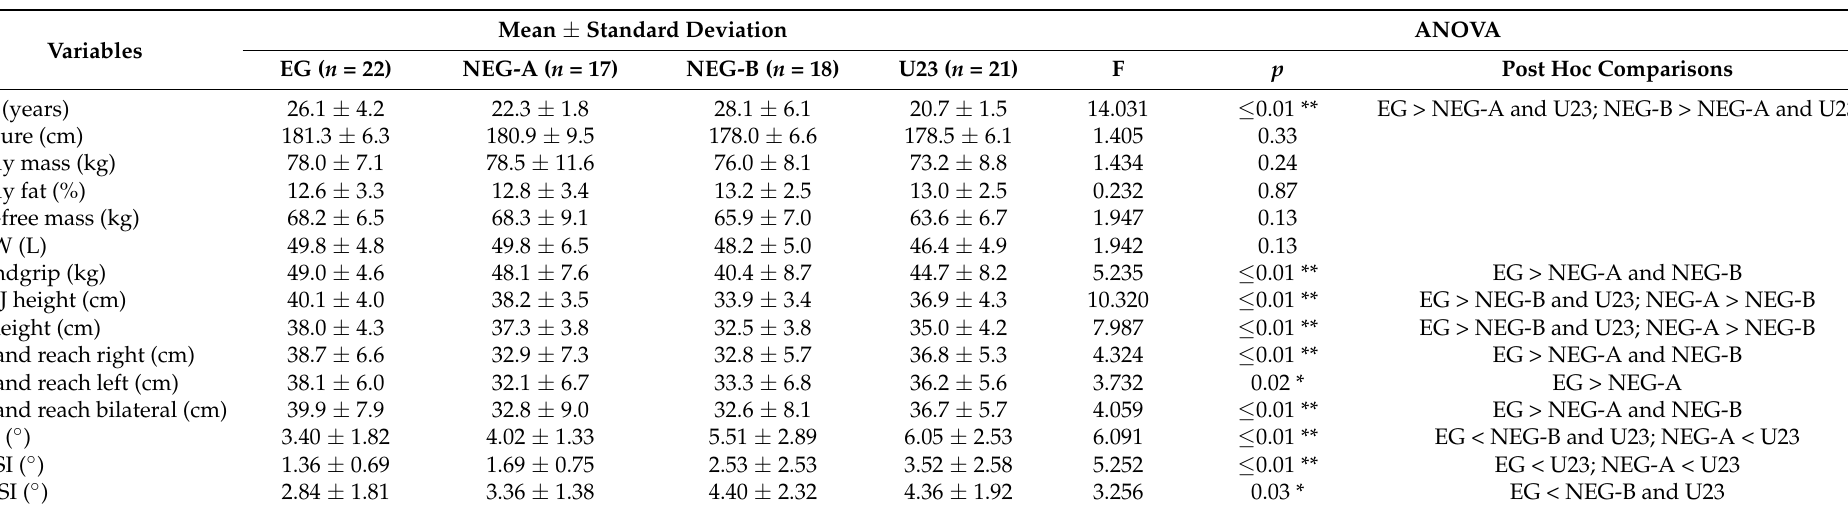
Table 1. Descriptive statistics for chronological age, body composition, strength, flexibility, and balance tests, and results of the one-way between-group